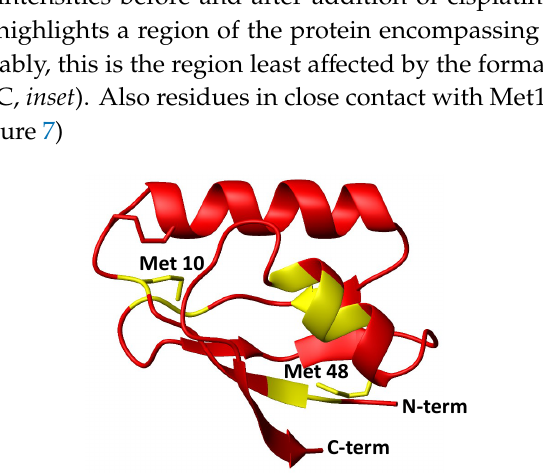
Figure 7. Mapping of residues with an intensity ratio (I / I 0 ) below average, shown in yellow on the structure of oxidized Atox1 given in red. The I / I 0 ratio was calculated at resonance positions of backbone amides of oxidized Atox1, using 1 H, 15 N HSQC spectra recorded in the presence of GSH / GSSG after 1 h of incubation with cisplatin (I) and in the absence of cisplatin (I 0 ).